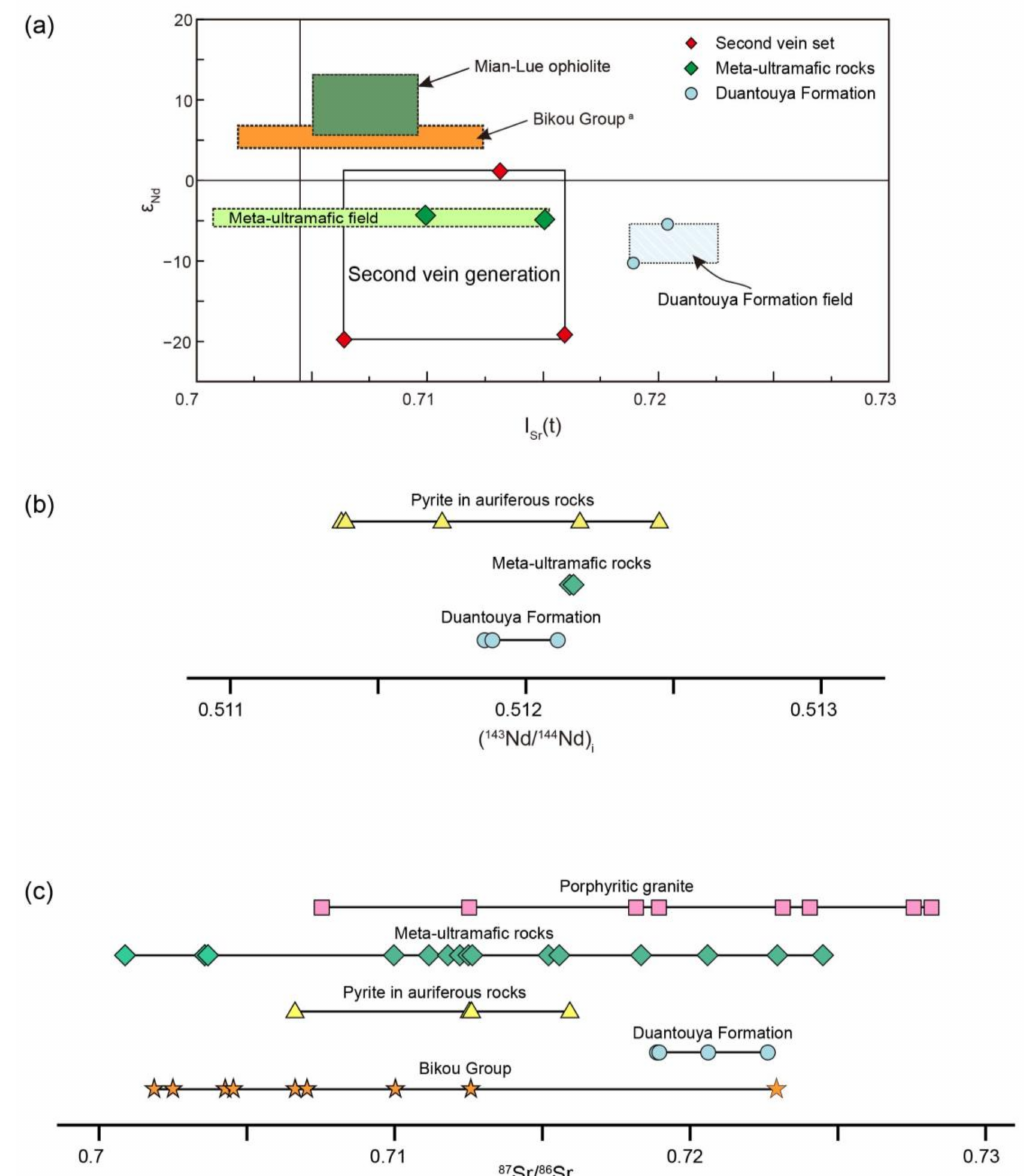
Figure 10. Isotope systematics for the Jianchaling Au deposit showing: ( a ) I Sr (t) versus ε Nd (t) plot (data for the Bikou Group is from [86]); ( b ) ( 143 Nd/ 144 Nd)i plot; and ( c ) 87 Sr/ 86 Sr plot. The range of the Mian-lue ophiolite is from [23]. T = 198